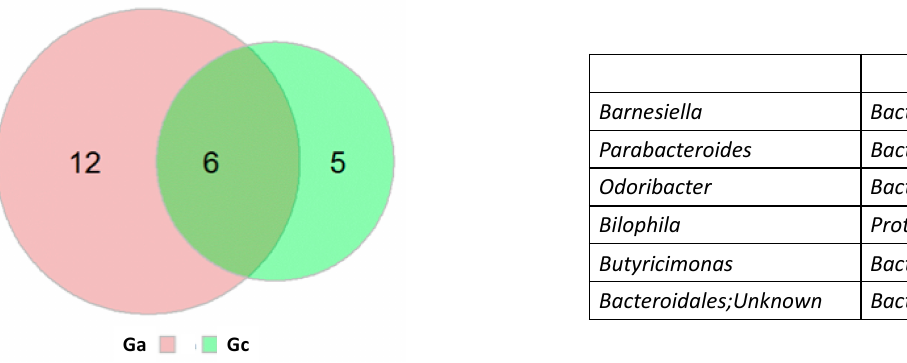
Figure 3. Six bacteria were overlapping between Ga and Gc. Size of the Venn diagram is shown in proportion to the number of bacteria in each group. Bacterial names and direction of changing relative abundance are shown on the right.